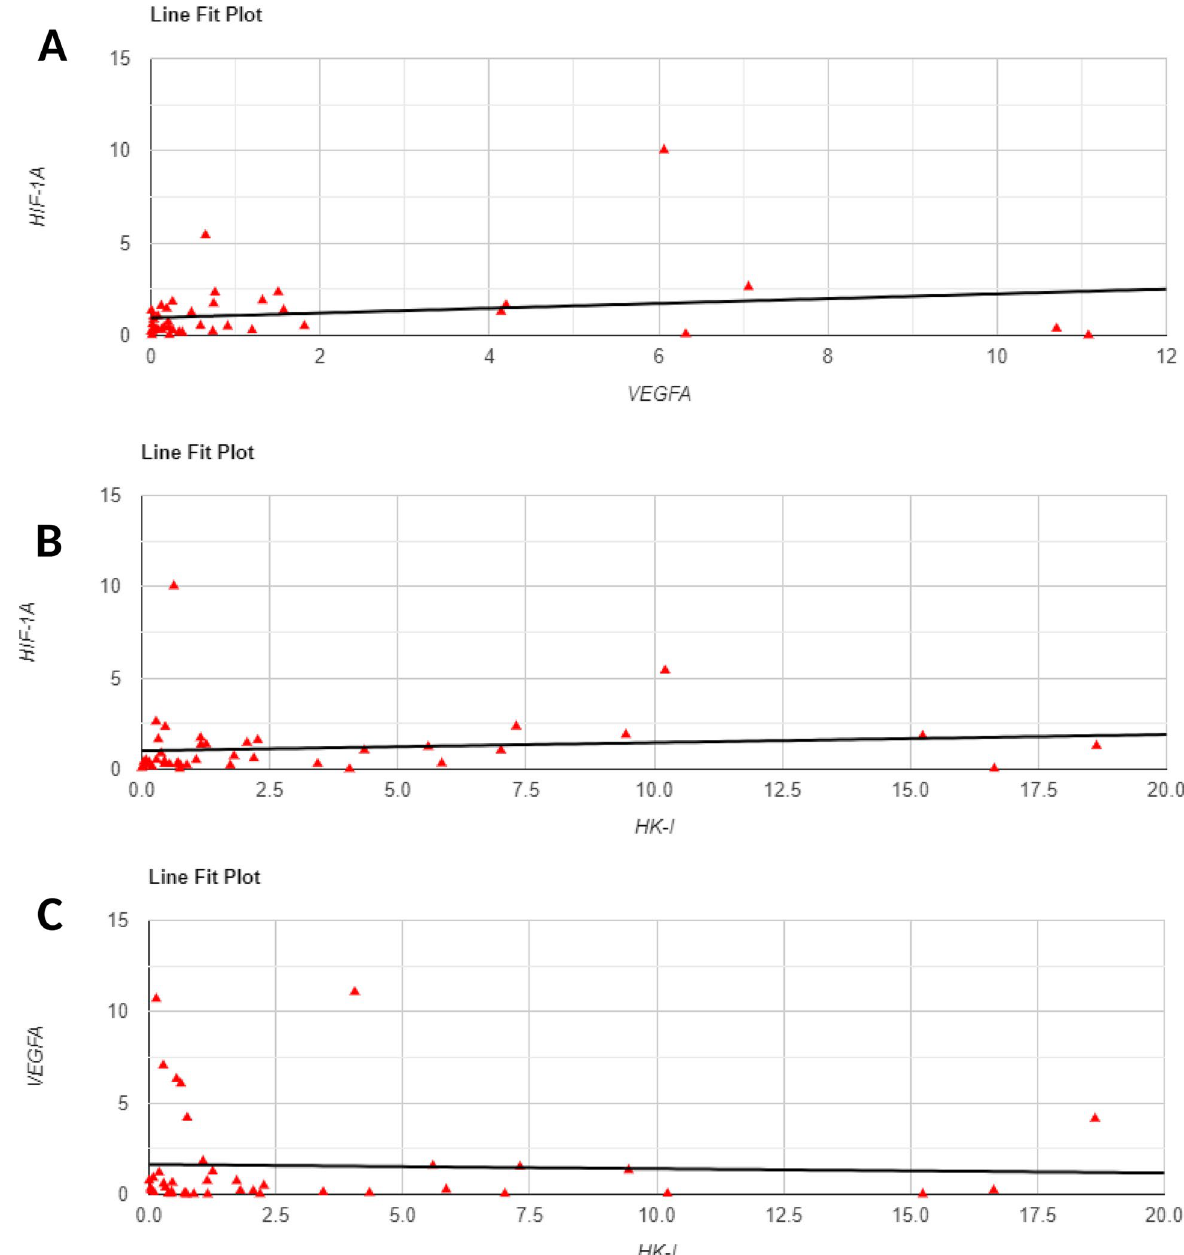
Fig. 5 Spearman correlation coefficients: Correlation coefficients between ( A ) Hypoxia-inducible factor-1 alpha (HIF-1α) and vascular endothelial growth factor-A (VEGFA) expression ( B ) HIF-1α and HK-I ( C) VEGFA and